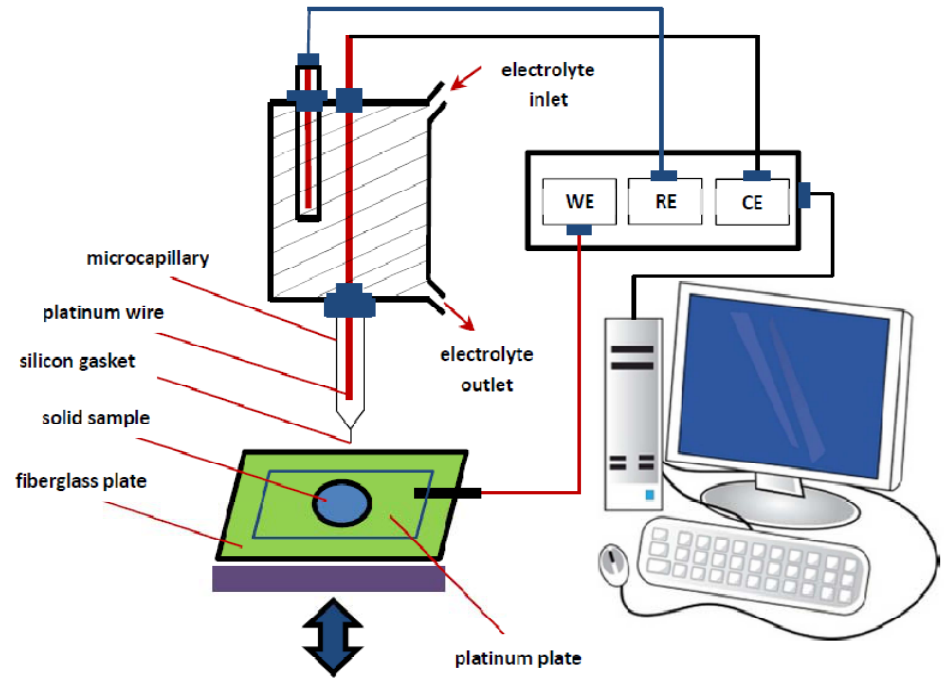
Figure 10. Schematic drawing of the set-up of the capillary-based droplet